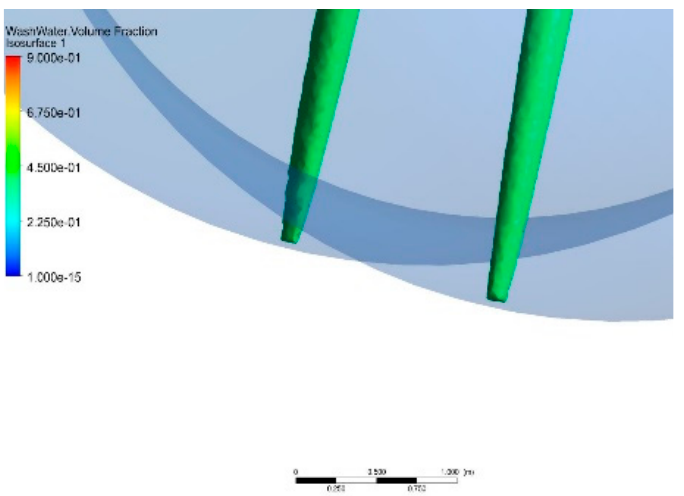
Figure 18. Scrubber Wash Water Volume Fraction of 0.41 isosurface development—probe sphere detail.